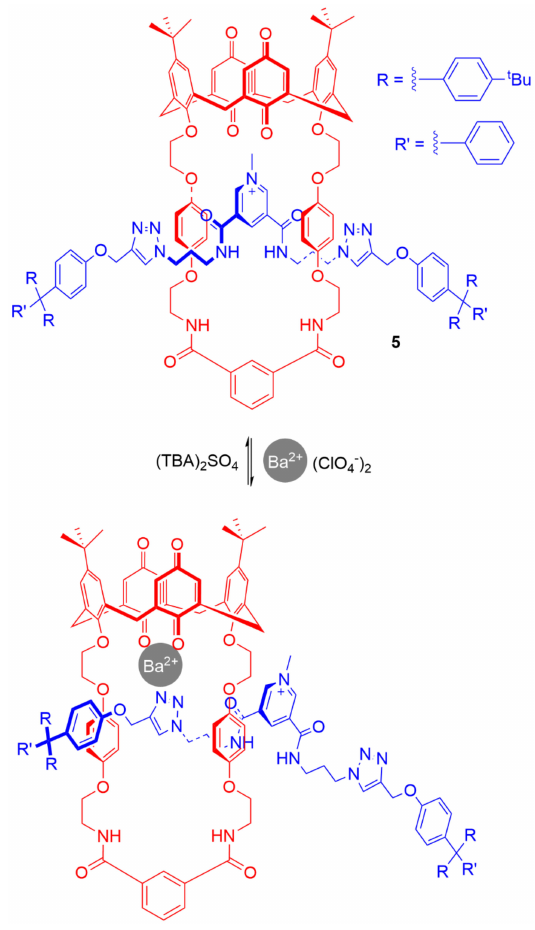
Figure 5. Barium cation-induced motion in Leontiev and Beer’s calix[4]diquinone–isophthalamide macrobicycle rotaxane 5